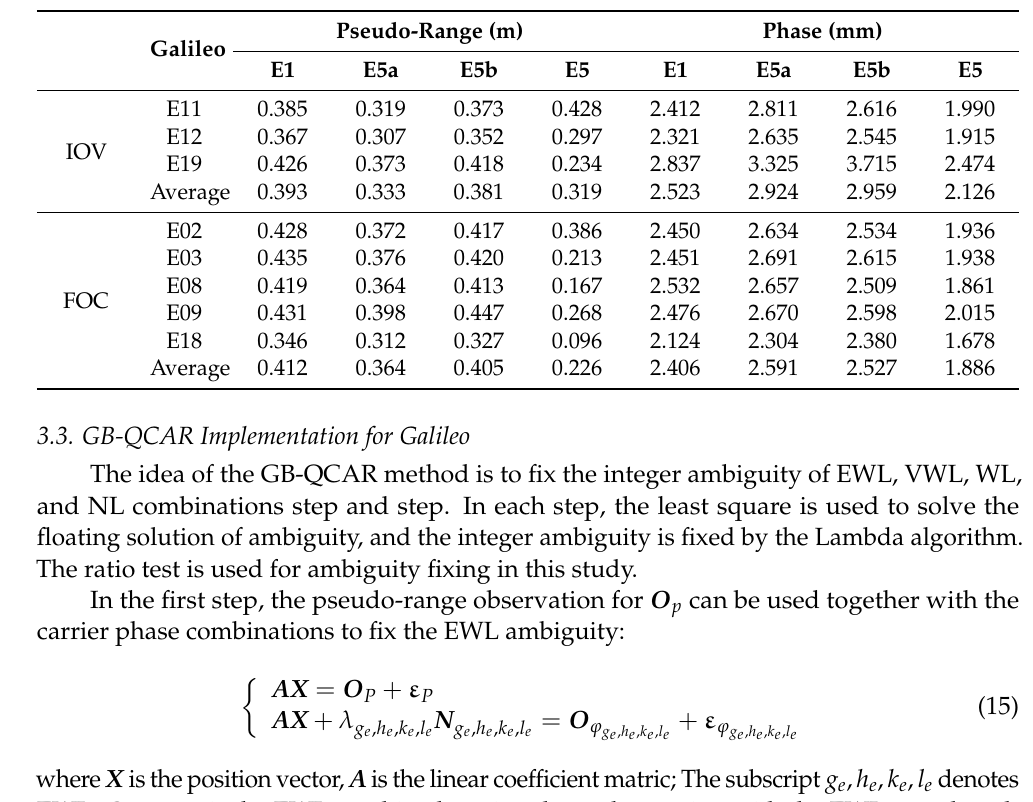
Figure 10. Phase and pseudo-range single-difference residuals of E19 satellite ( a ): Phase; ( b ): Pseudo-range. Table 3. Accuracy of pseudo-range and carrier phase observation (RMS).